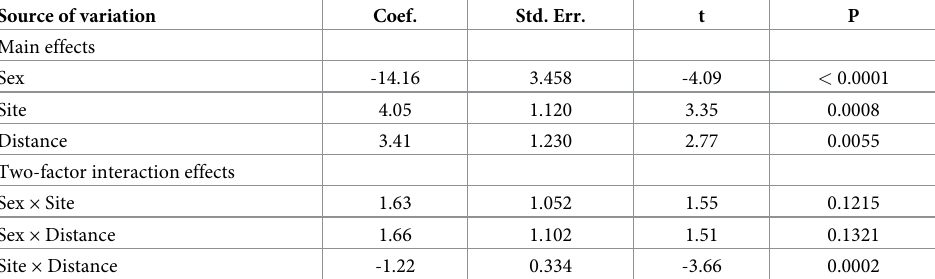
Table 3. Result of the general linear mixed model for excess attenuation (EA) of propagated songs of the Yellow- breasted Boubou ( Laniarius atroflavus ). Main and two-factor interactions effects are presented for the following source of variation: sex (male, female), site (transect FOREST, SHRUBS, STREAM) and distance (12.5, 25, 50 and 100 m). Repeated measurements of songs of the same individuals are included as a random factor. Source of variation